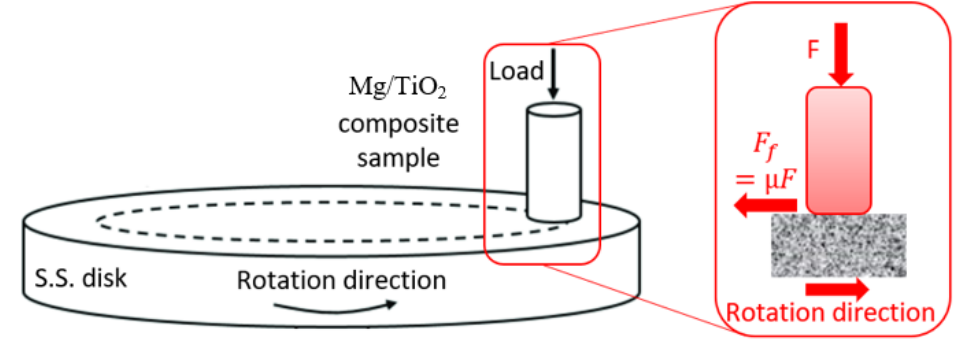
Figure 3. Schematic diagram for the wear test.